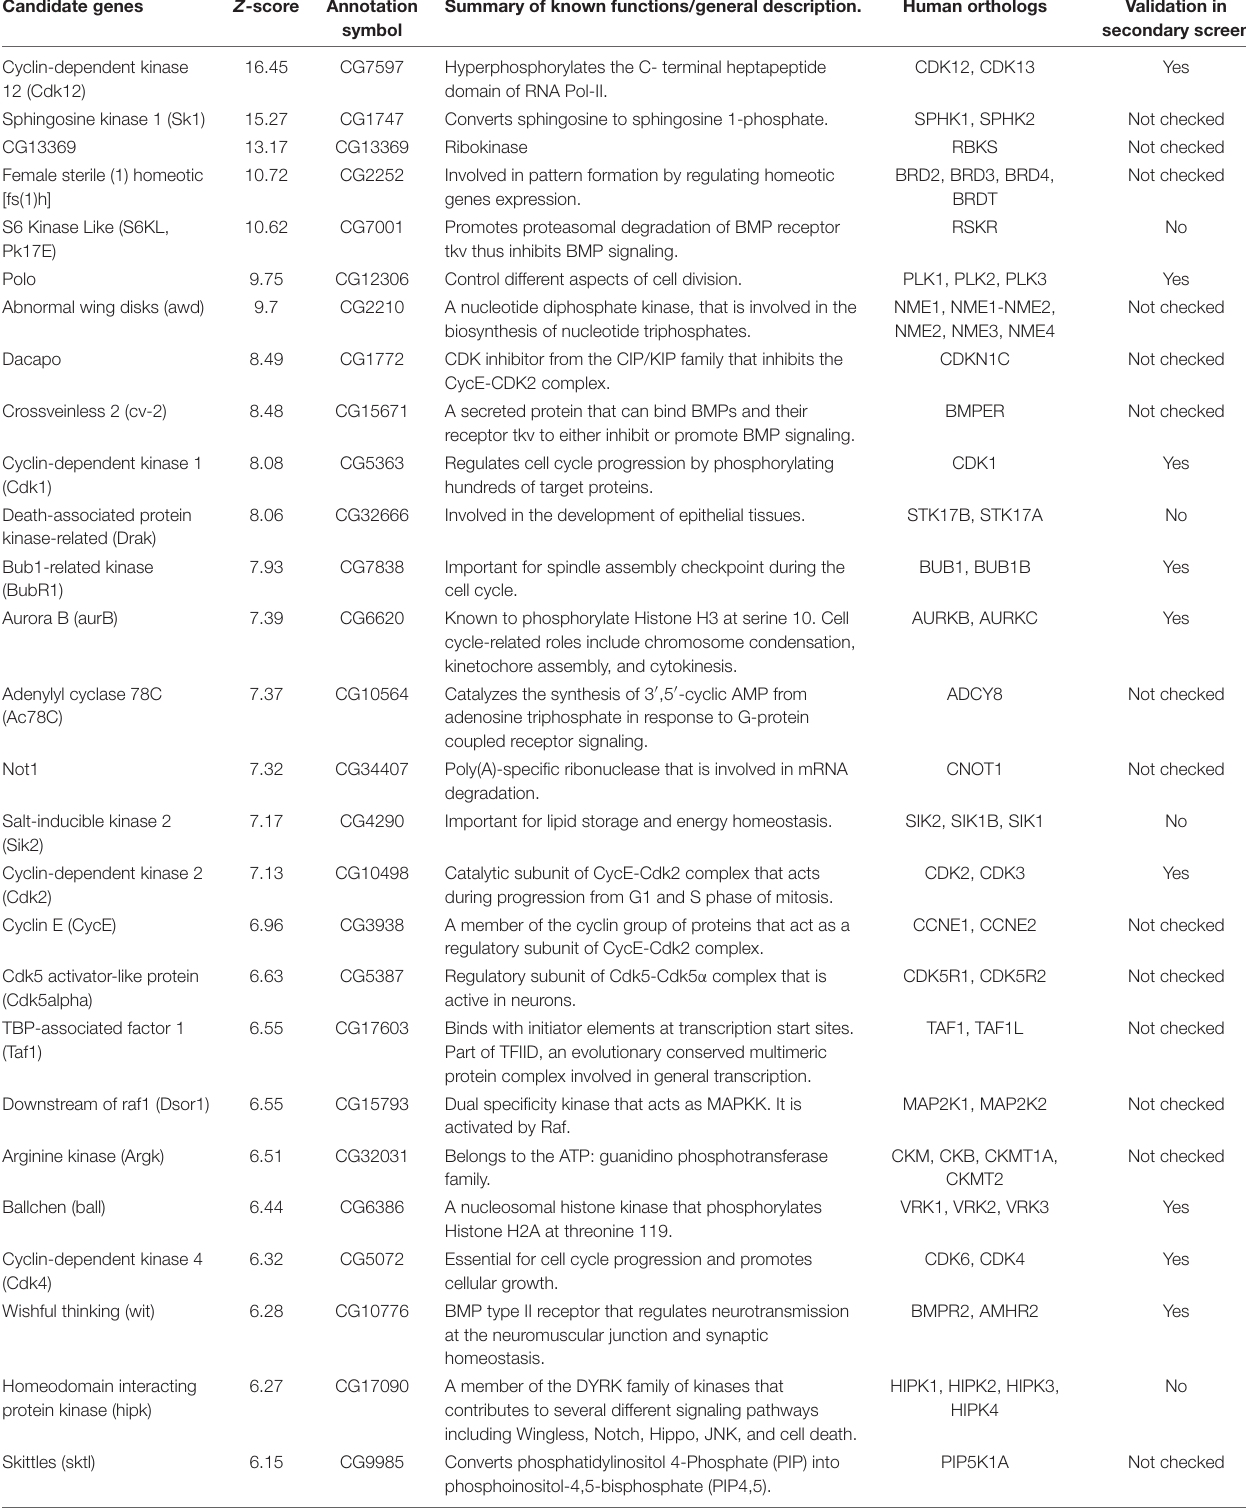
TABLE 1 | List of candidate genes along with their respective Z-scores, annotation symbols, human orthologs, and a summary of their known functions. Candidate genes Z -score Annotation